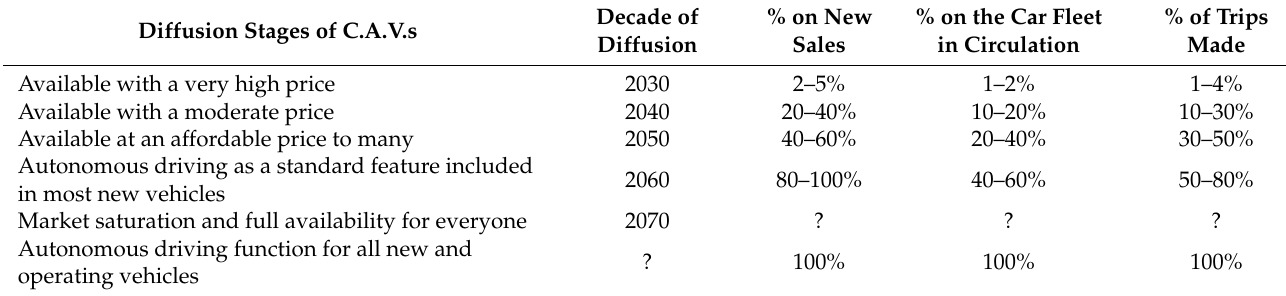
Table 1. Timing estimation concerning the introduction and diffusion of CAVs in the car